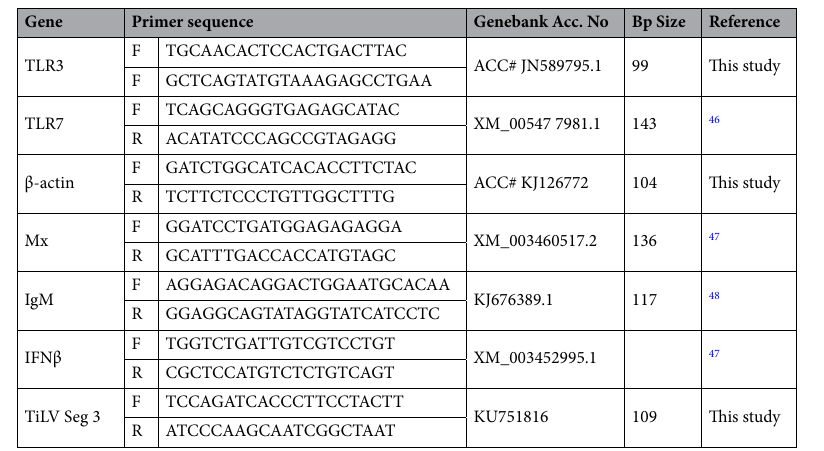
Table 1. Primers used for gene expression